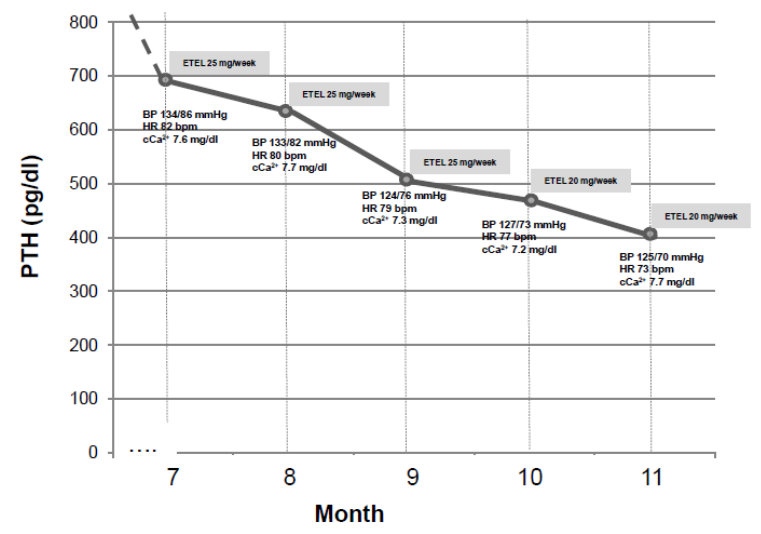
Figure 4. Variations of blood pressure, heart rate, albumin corrected-serum calcium in response to iPTH reduction induced by ETEL (Etelcalcetide).